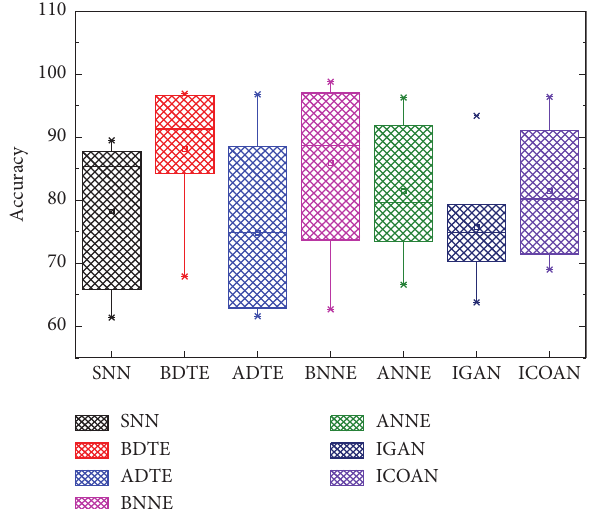
Figure 7: Comparison of the methods on the